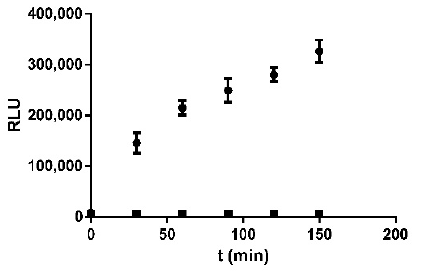
Figure 1. Comparison of luminescence produced by ArLuc- 1 in presence ( ● ) or absence ( ▪ ) of Monoacylglycerol lipase (MAGL). Data represent mean ± standard deviation (SD).